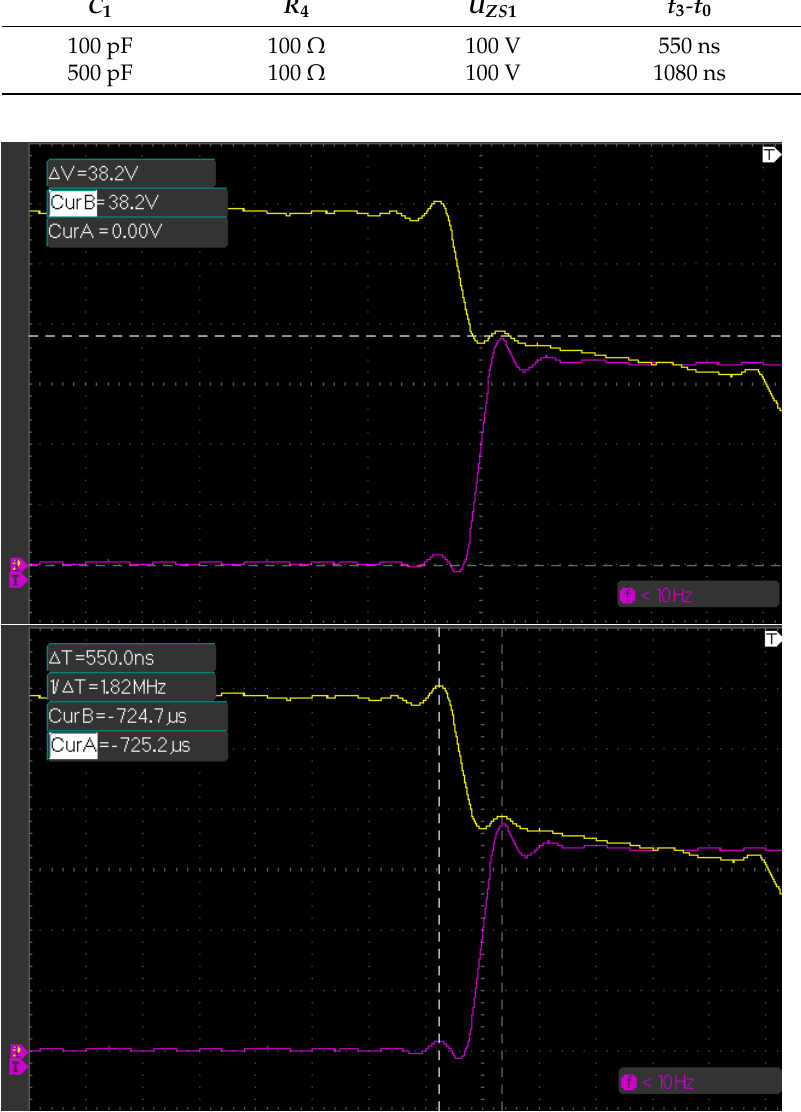
Figure 14. C 1 = 100 pF turn-off